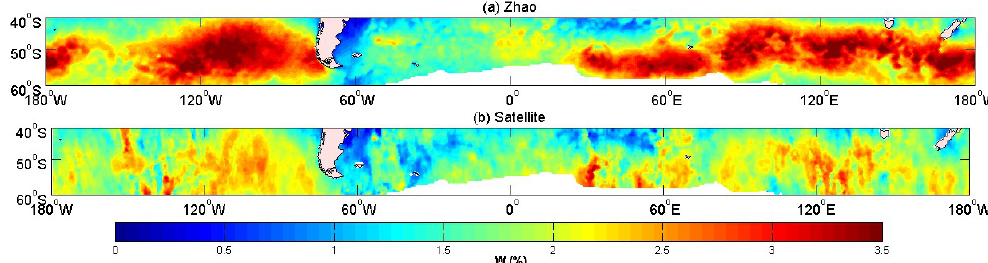
Figure 8. Distribution of the whitecap coverage over 40 ◦ S–60 ◦ S and 180 ◦ E–180 ◦ W. ( a ) The results of Zhao’s whitecap coverage relationship [45], and ( b ) satellite-derived results [20].